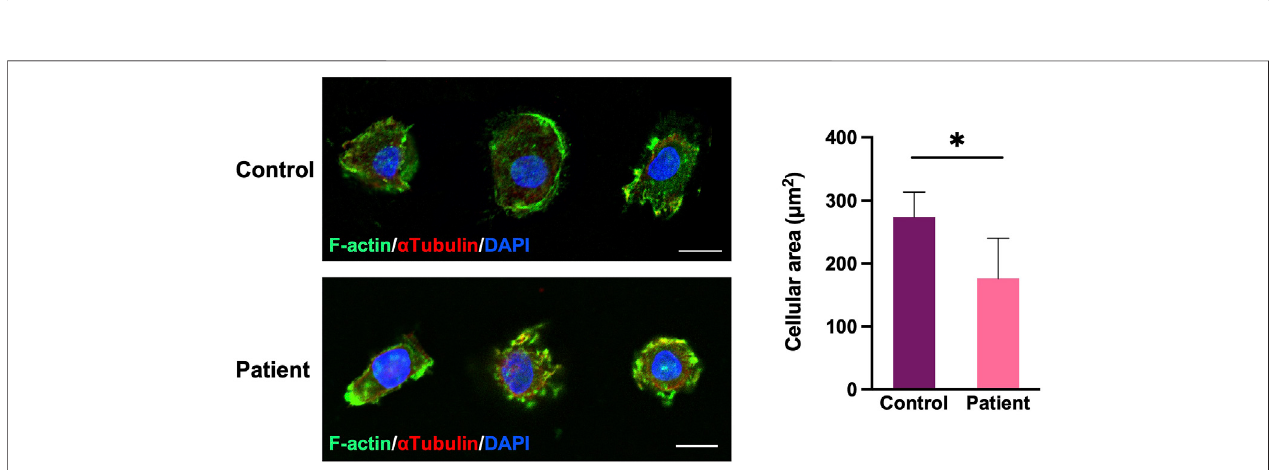
FIGURE 5 | Cell morphology and fi lamentous actin (F-actin) of the cytoskeleton of PBMCs. PBMCs double labeled for F-actin (green) and a -tubulin (red). The patient ’ s PBMCs extended into a smaller range, resulting in a signi fi cant decrease in the area of a single PBMC ( n = 20 cells in each group; * p < 0.05, two-tailed t test ). Scale bar, 10 μ